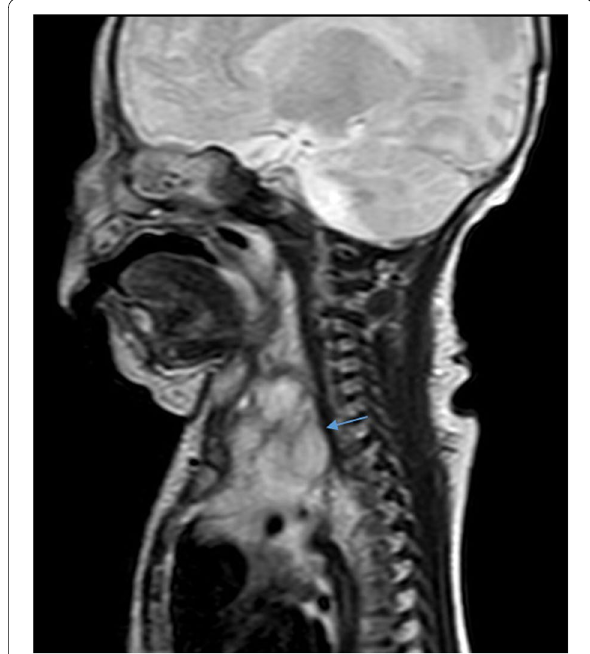
Fig. 2 T2-weighted sagittal MR images, heterogenous, hyperintense mass, extending into the mediastenum and surrounding the trachea